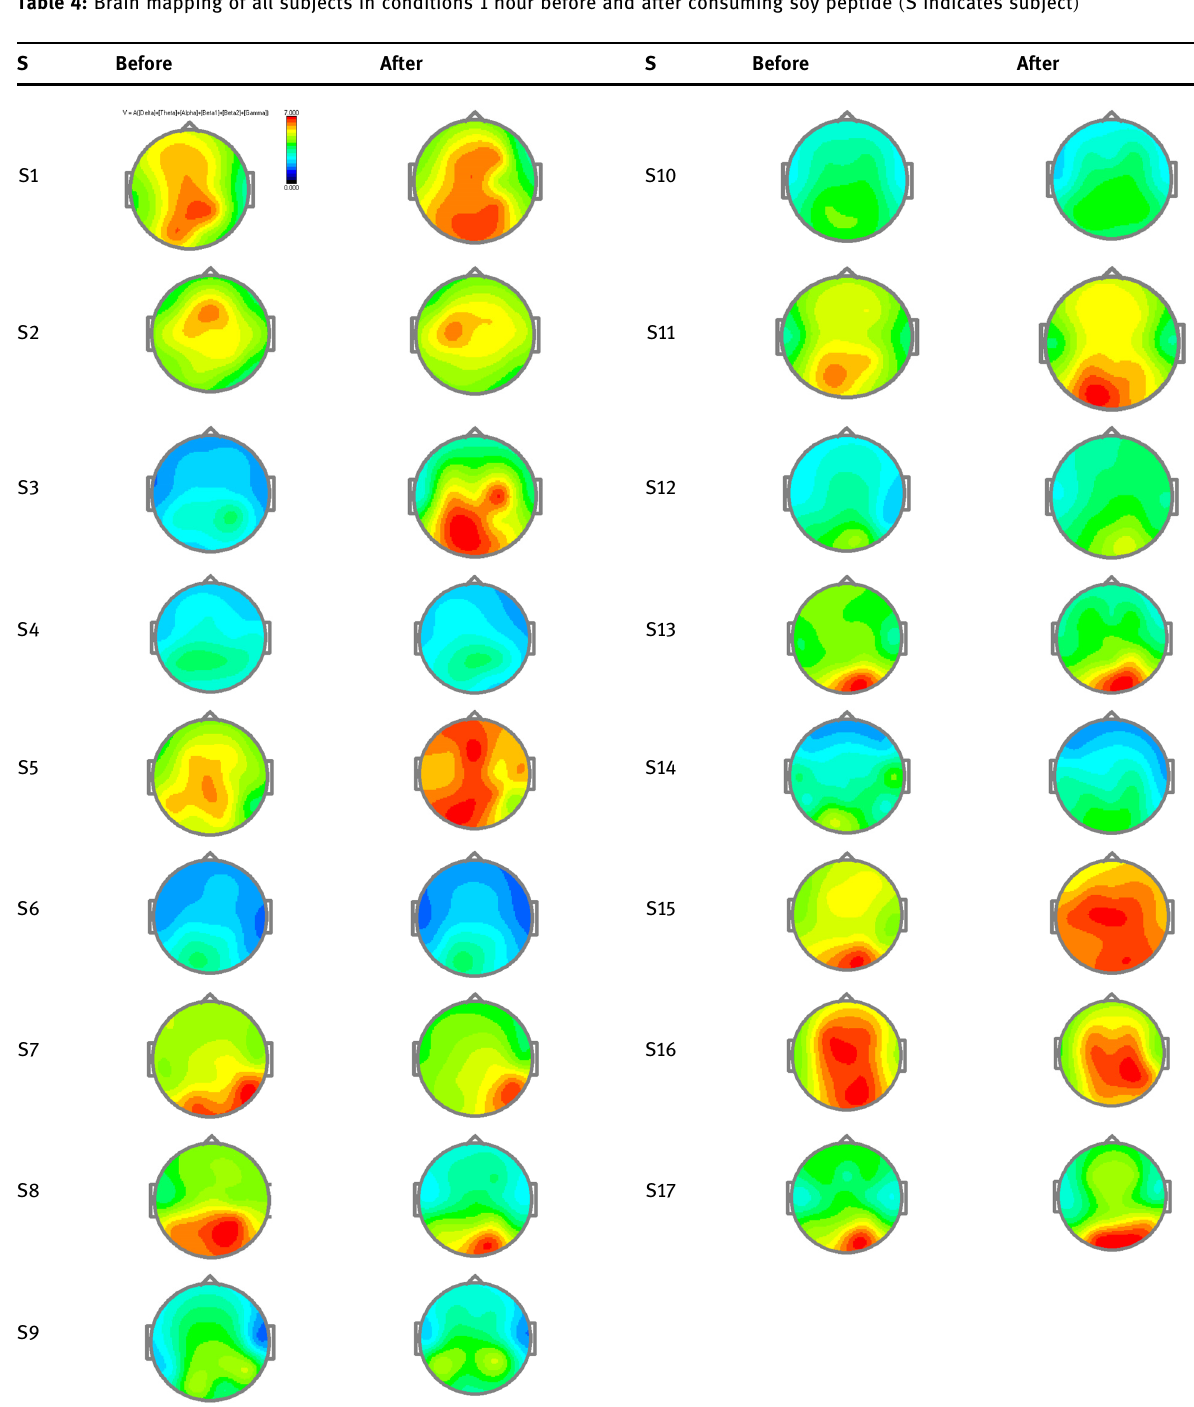
Table 4: Brain mapping of all subjects in conditions 1 hour before and after consuming soy peptide ( S indicates subject )